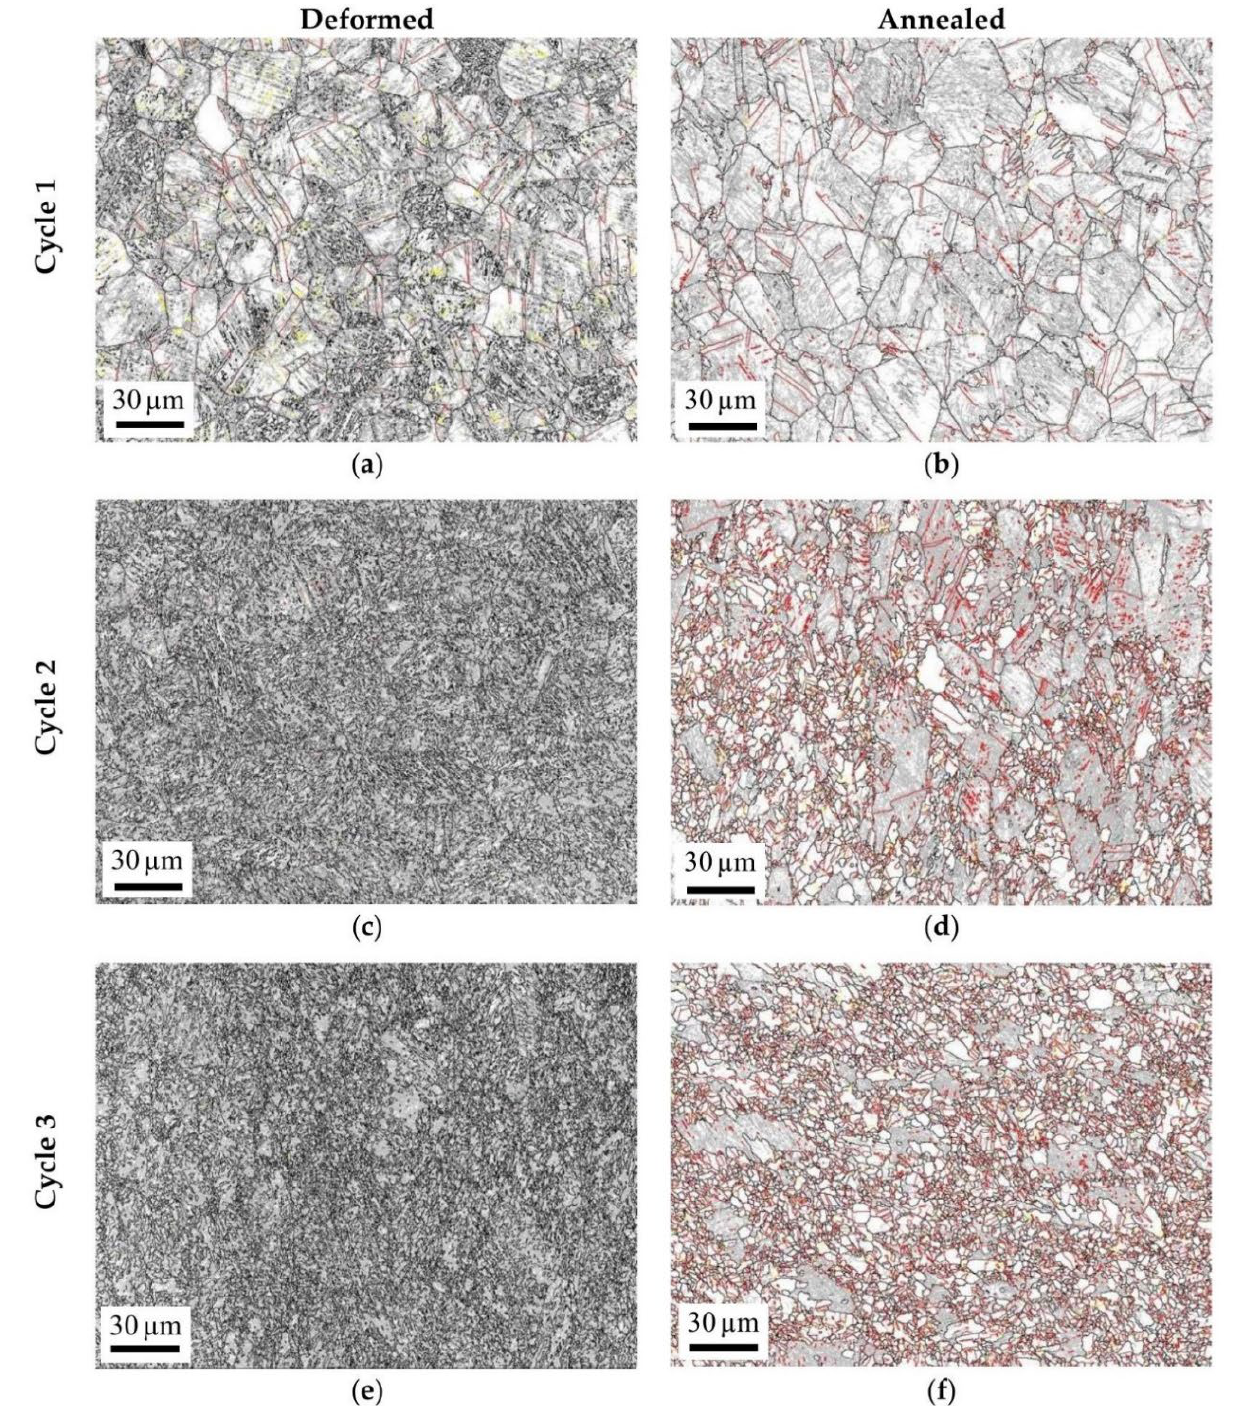
Figure 7. Grain boundaries construction maps for TMP samples processed using three cycles and a strain of 0.15: ( a , b ) Cycle 1, ( c , d ) Cycle 2, and ( e , f ) Cycle 3.